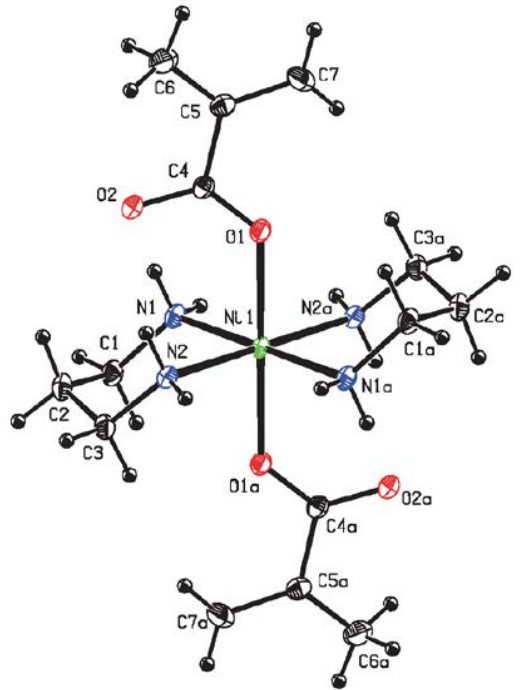
Fig. 2. The ORTEP view of complex 2 showing 30% probability thermal ellipsoids